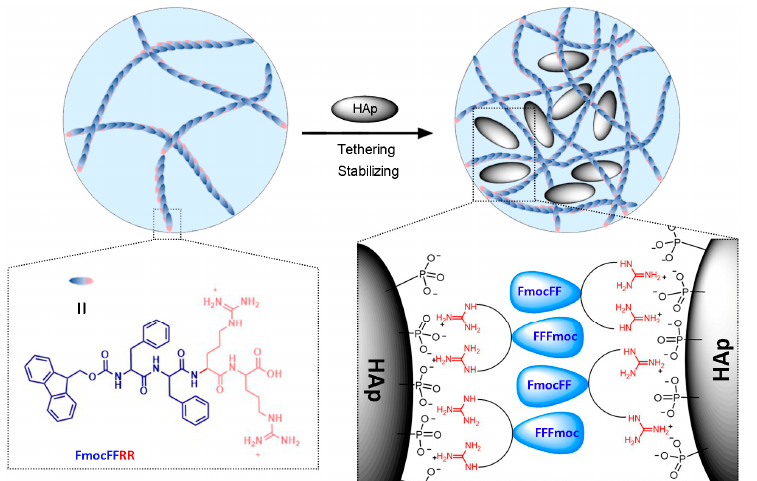
Figure 1. Schematic illustration of constructing FmocFFRR-tethering HAp hybrid hydrogel for Schematic illustration of constructing FmocFFRR-tethering HAp hybrid hydrogel HAp-stabilization. for